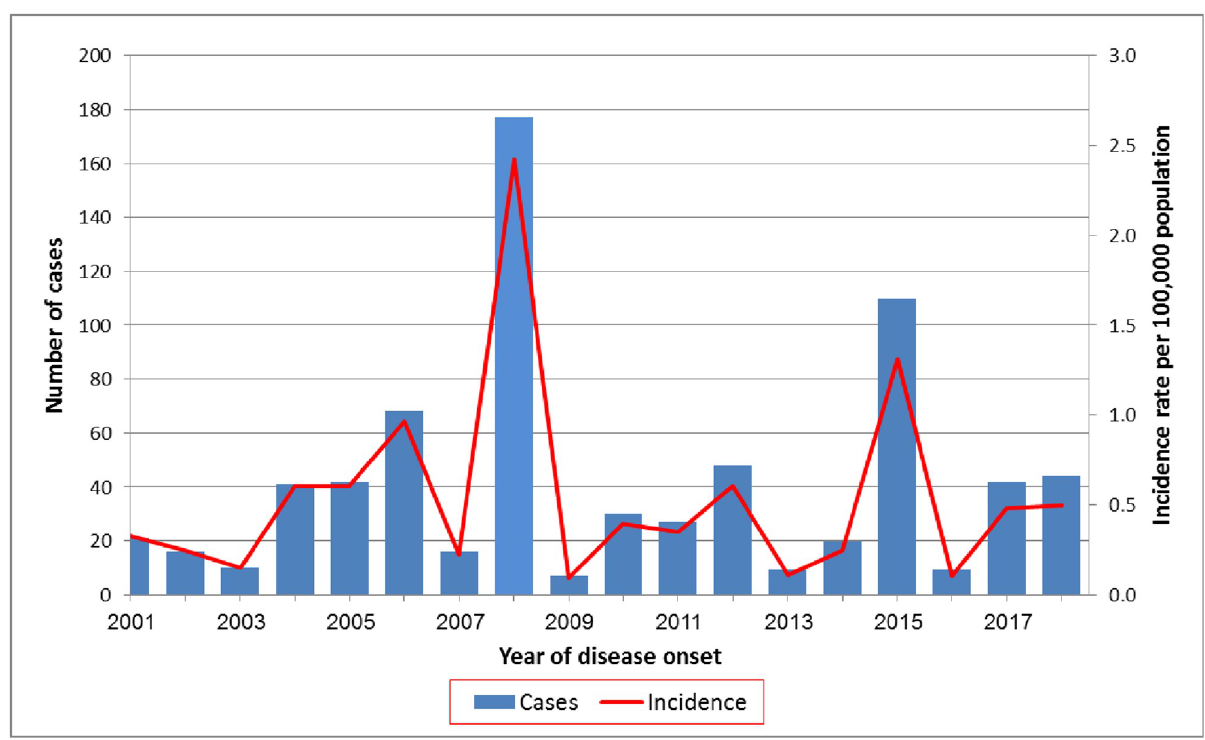
Fig 1. Reported Cryptosporidium cases in Israel and incidence rate